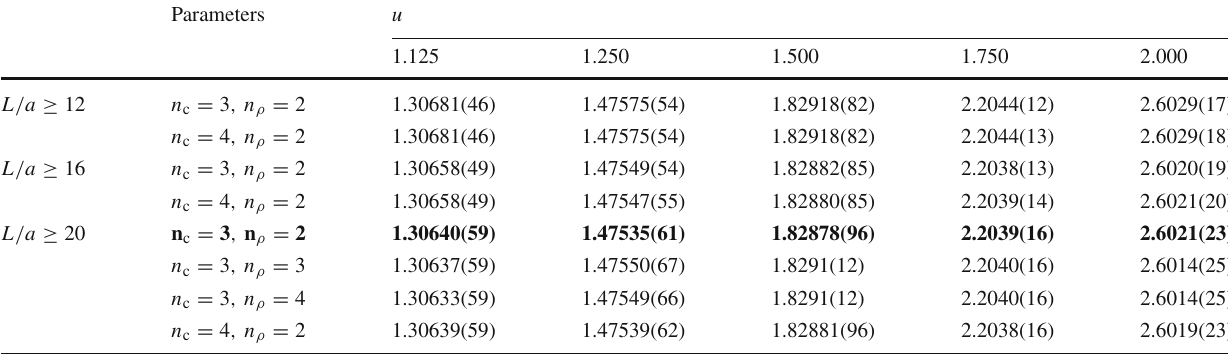
Table 1 Values of the continuum function J 1 ( u ) for different fit parametrizations and cuts (see Eq. (4.2)). In bold we show our preferred fit. See text for more details